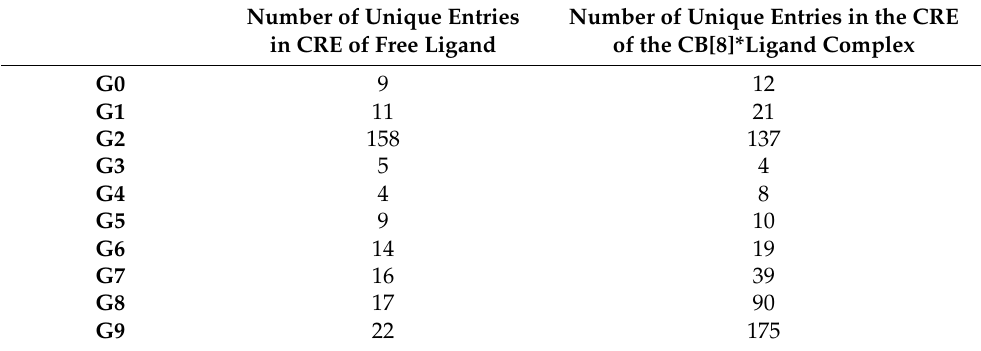
Table 1. Number of unique structures in the conformer/rotamer ensembles (CREs) of free ligands G0 – G9 and ligand-receptor complexes CB[8]*ligand prior to final re-ranking according to Gibbs free energies. Number of Unique Entries Number of Unique Entries in the CRE in CRE of Free Ligand